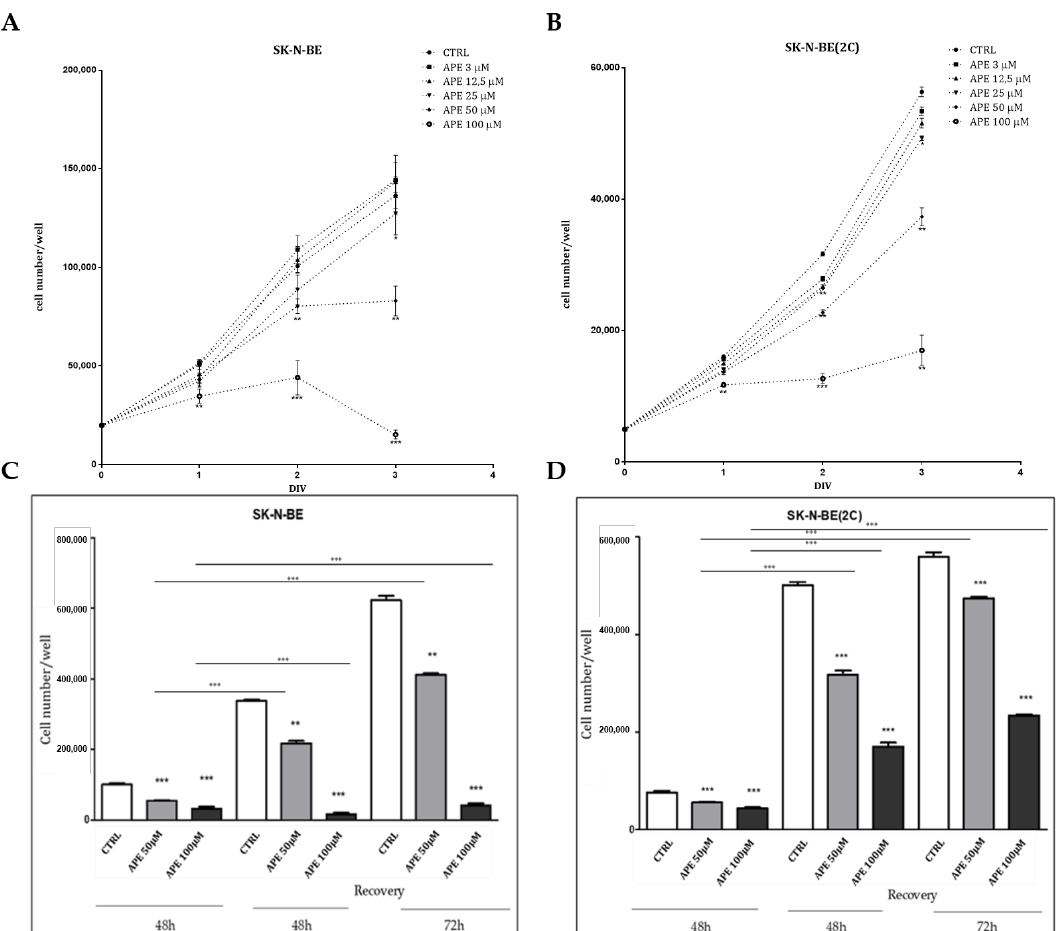
Figure 2. Analysis of cell growth by MTT assay in SK-N-BE ( A ) and SK-N-BE(2C) ( B ) cells upon M2 agonist APE treatment at the indicated concentrations (ranging from 3 to 100 μM) for 24 , 48 and 72 h (DIV = days in vitro). The data represented are the average ± SEM of four independent experiments conducted in triplicate (* p < 0.05; ** p < 0.01; *** p < 0.001). An ANOVA test was used to statistically compare all experimental conditions. Recovery analysis was assessed by MTT assay in SK-N-BE ( C ) and SK-N-BE(2C) ( D ) cell lines upon 50 or 100 µM APE treatment for 48 h; then, the agonist was removed from the culture medium and the cells were maintained in a fresh complete medium for an additional 48 and 72 h. The data show the recovery of cell proliferation after 50 µM APE in both cell lines (** p < 0.01; *** p < 0.001). Instead, after 100 µM APE, only SK-N-BE(2C) was able to rescue cell proliferation (*** p < 0.001; APE. Respective to CTRL). The results are the mean ± SEM of at least three independent experiments conducted in triplicate. (* on the bars indicates the comparison of samples after APE withdrawal vs. respective APE treatment; *** p < 0.001). All the data were obtained in three independent experiments performed in triplicate.